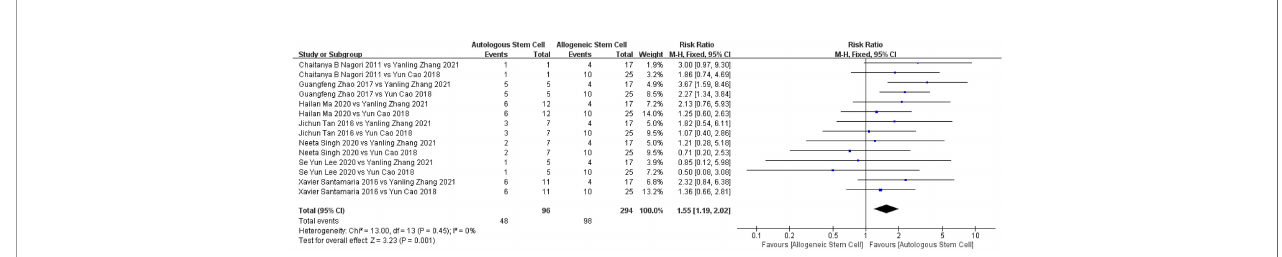
FIGURE 6 | Comparison of pregnancy rate of autologous and allogeneic stem cells in treatment of IUA.